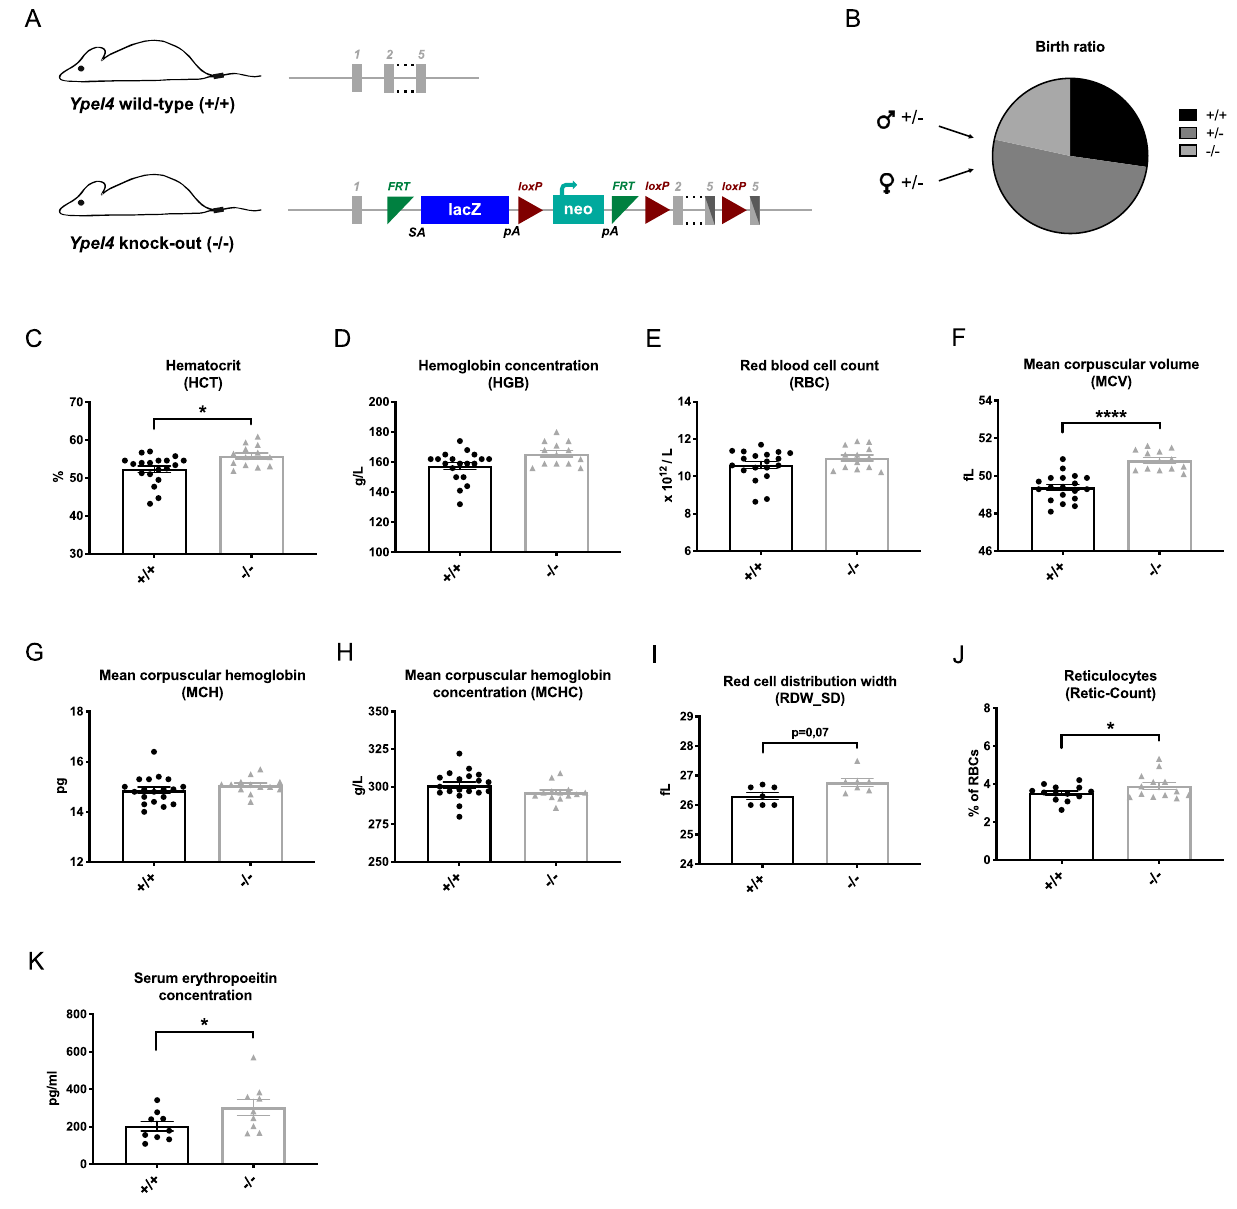
Figure 1. Disruption of the Ypel4 gene results in a macrocytic secondary polycythemia. ( A ) Schematic of the Ypel4 wild-type (+) and knockout (−) allele in the mouse model (image adapted from https:// www. mouse pheno type. org 49 ). ( B ) Breeding statistics of breeding pairs carrying one wild-type and one knock-out allele (+/−) each (n = 19–45). ( C ) Peripheral blood analysis of hematocrit (HCT) (n = 13–19); ( D ) Hemoglobin concentration (HGB) (n = 13–19); ( E ) Red blood cell count (RBC) (n = 13–19); ( F ) Mean corpuscular volume (MCV) (n = 13–19); ( G ) Mean corpuscular hemoglobin (MCH) (n = 13–19); ( H ) Mean corpuscular hemoglobin concentration (MCHC) (n = 13–19) and ( I ) Red cell distribution width (RDW_SD) (n = 7) by utilization of a hematology analyzer. ( J ) Percentage of reticulocytes in total red blood cells as quantified by flow cytometry (n = 13). ( K ) Erythropoietin concentration in serum as detected by enzyme-linked immunosorbent assay (ELISA) (n = 9). Data displayed as average ± SEM, *P ≤ 0.05, ****P ≤